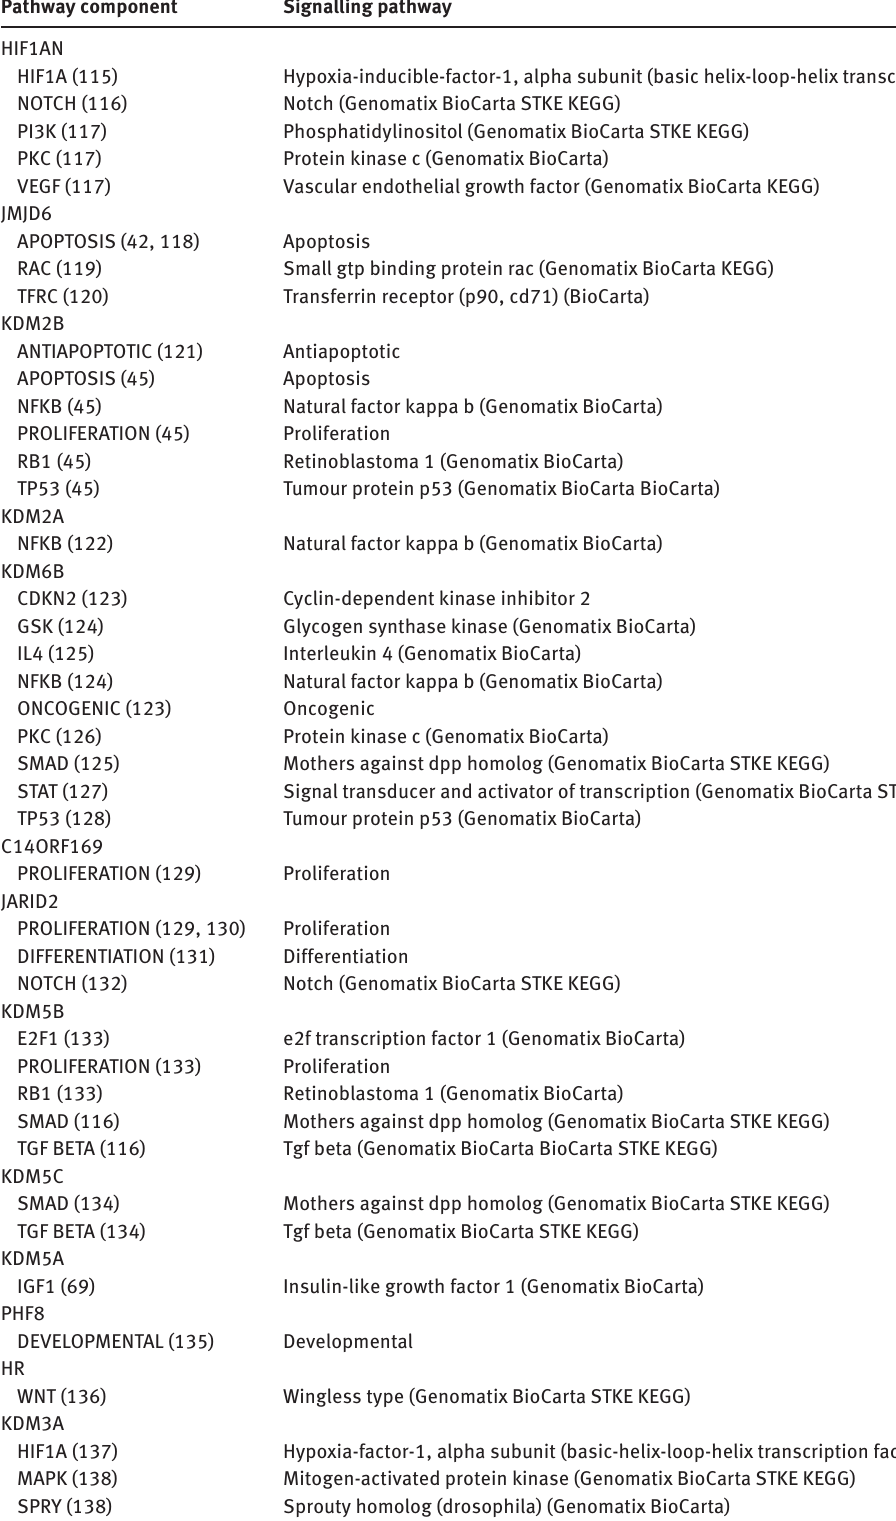
Table 3 Signal transduction pathway associations and potential interactions of JmjC proteins in human diseases. Pathway